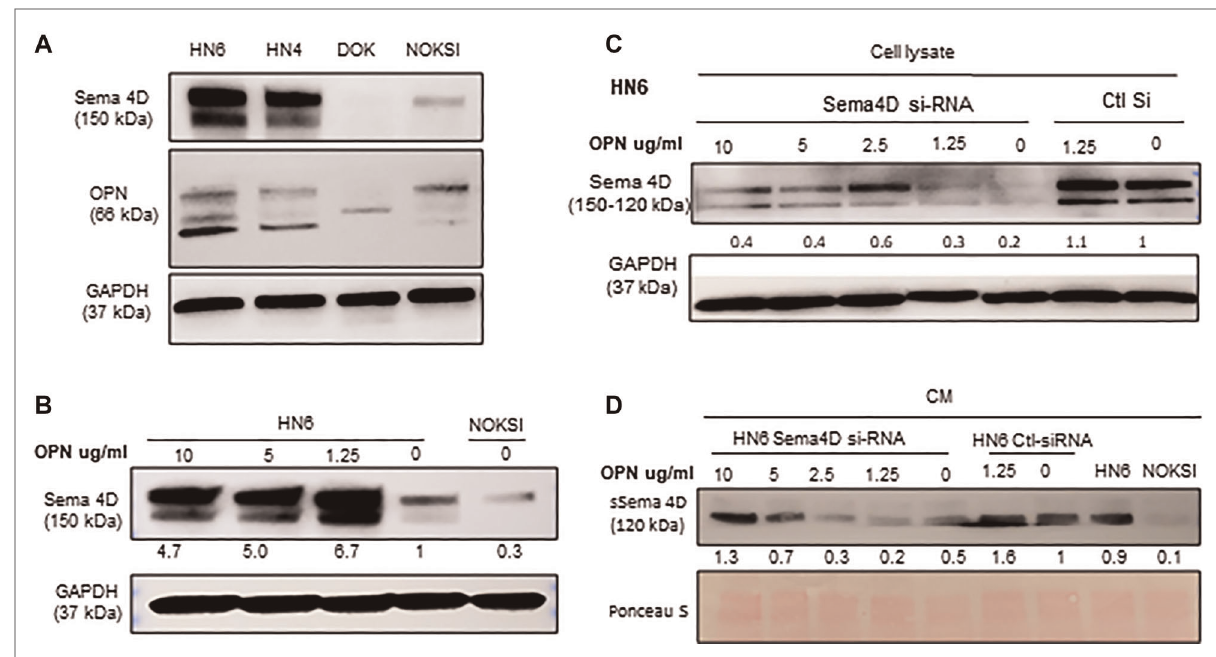
FIGURE 5 OPN plays a role in Sema4D regulation in the HNSCC HN6 cell line. ( A ) Immunoblot analysis demonstrates the basal level of OPN in HN6, HN4, DOK, and NOKSI. ( B ) Treatment of HNSCC with hr-OPN at different doses upregulates Sema4D in the cell lysate. ( C ) Sema4D inhibition in HN6 using